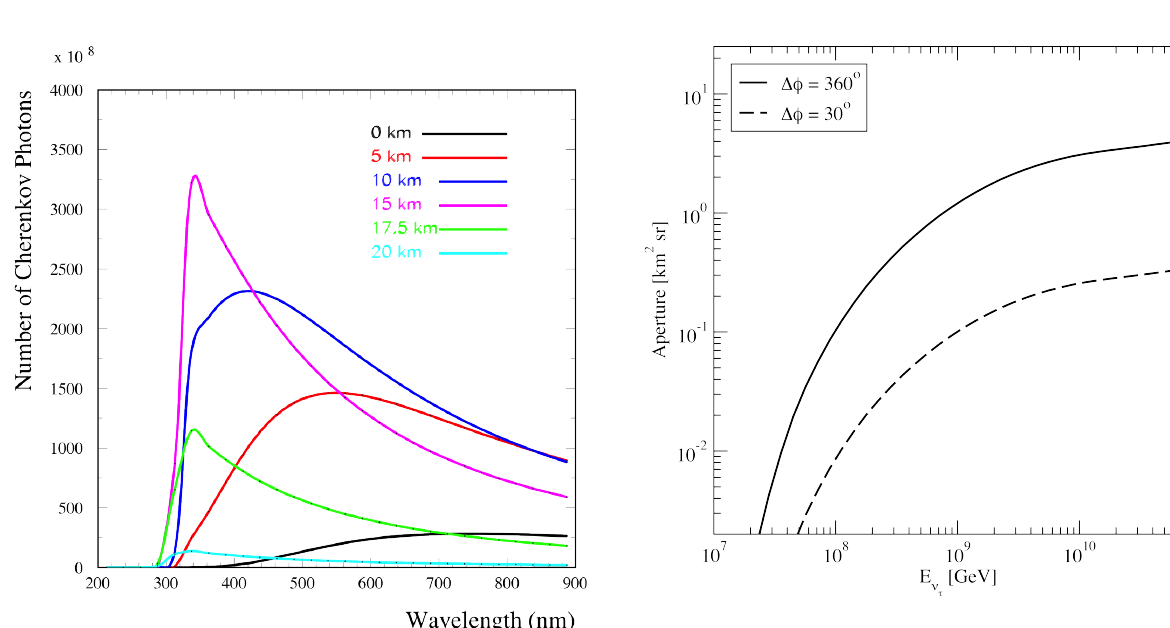
Figure 13. The e ff ective tau neutrino aperture as a function of energy assuming the ability to view an azimuthal range of 30 ◦ and 360 ◦ . From Ref.